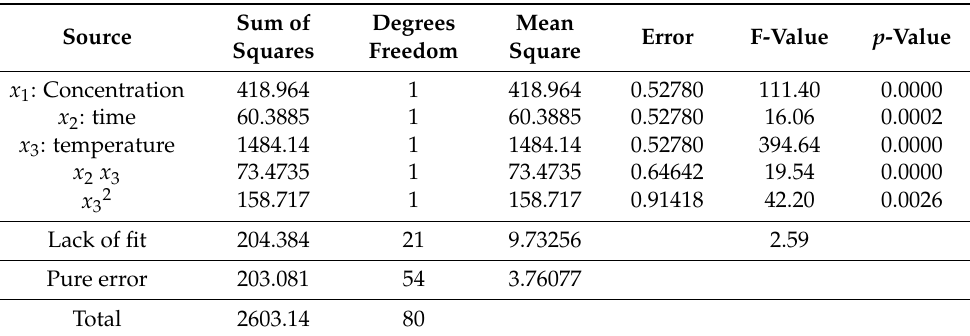
Table 3. Analysis of variance (ANOVA) for DPPH radical scavenging activity of the extracts of Welsh onion leaves.